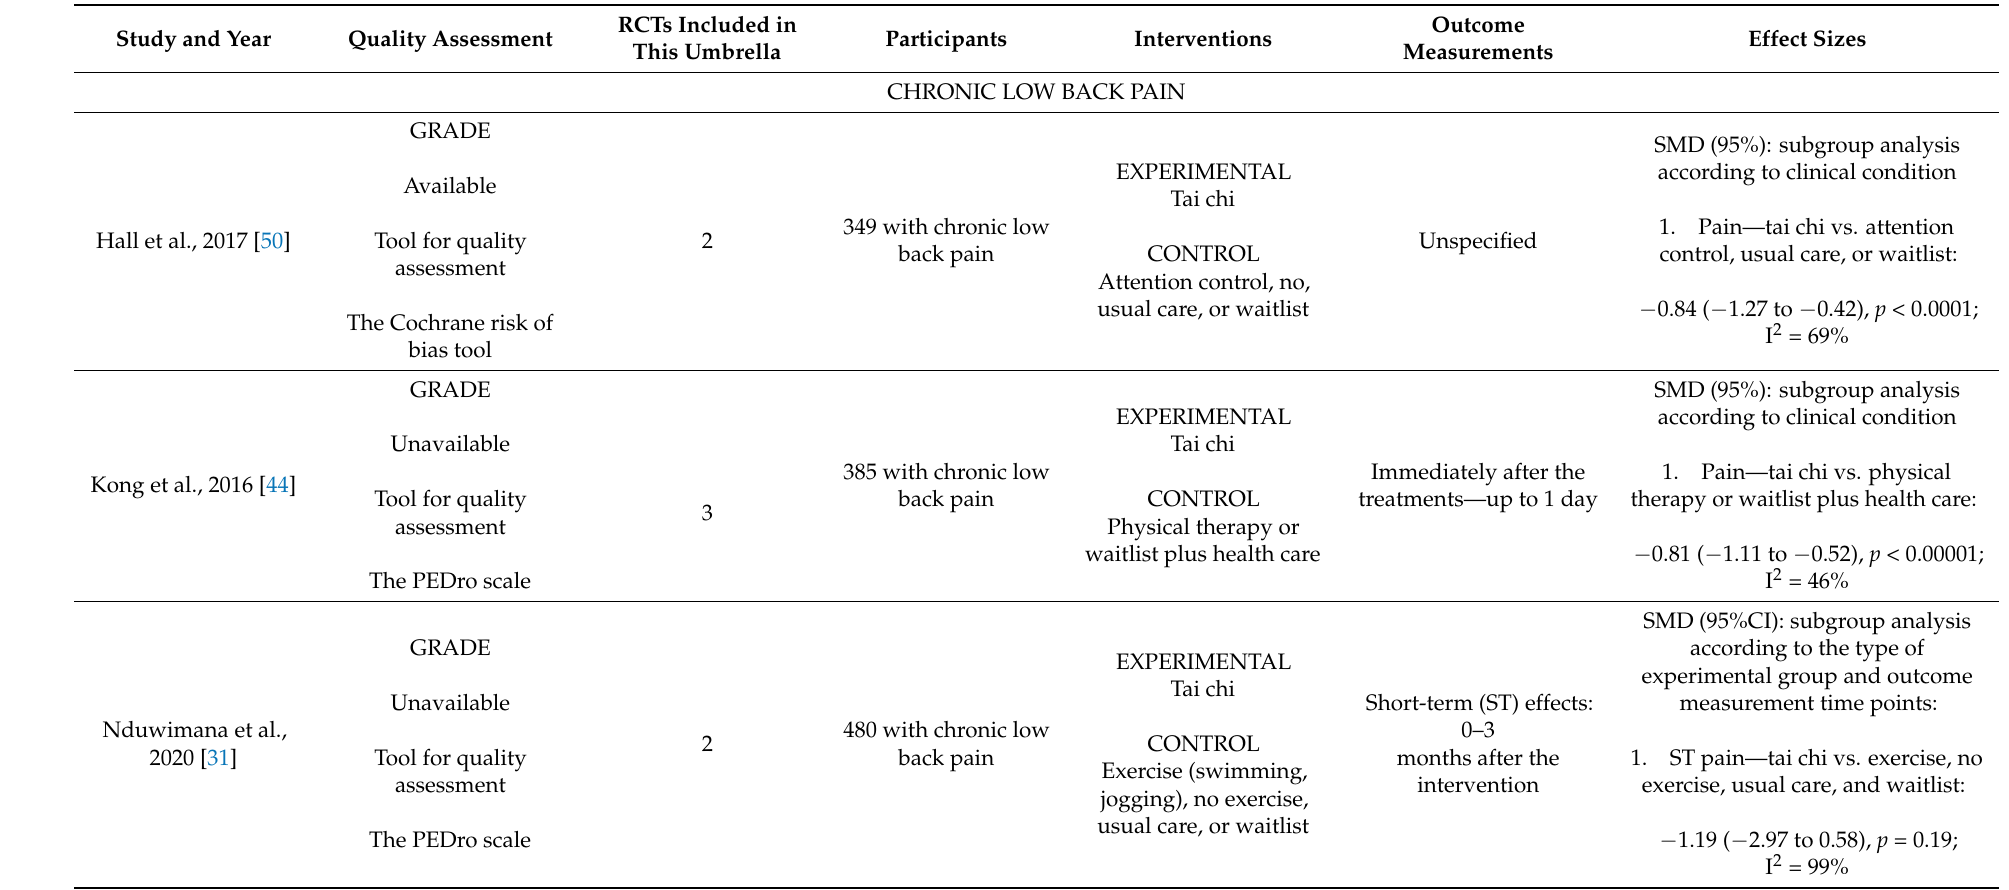
Table 3. Included reviews: tai